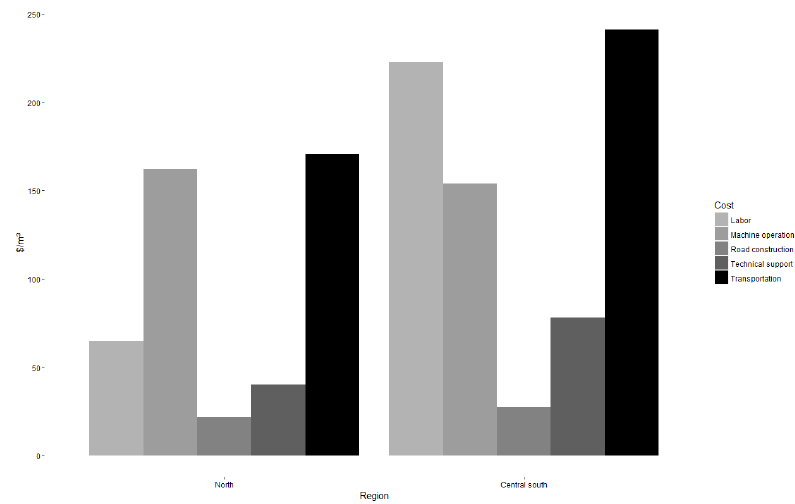
Figure 6. Mean values of analyzed costs for north and central south region.